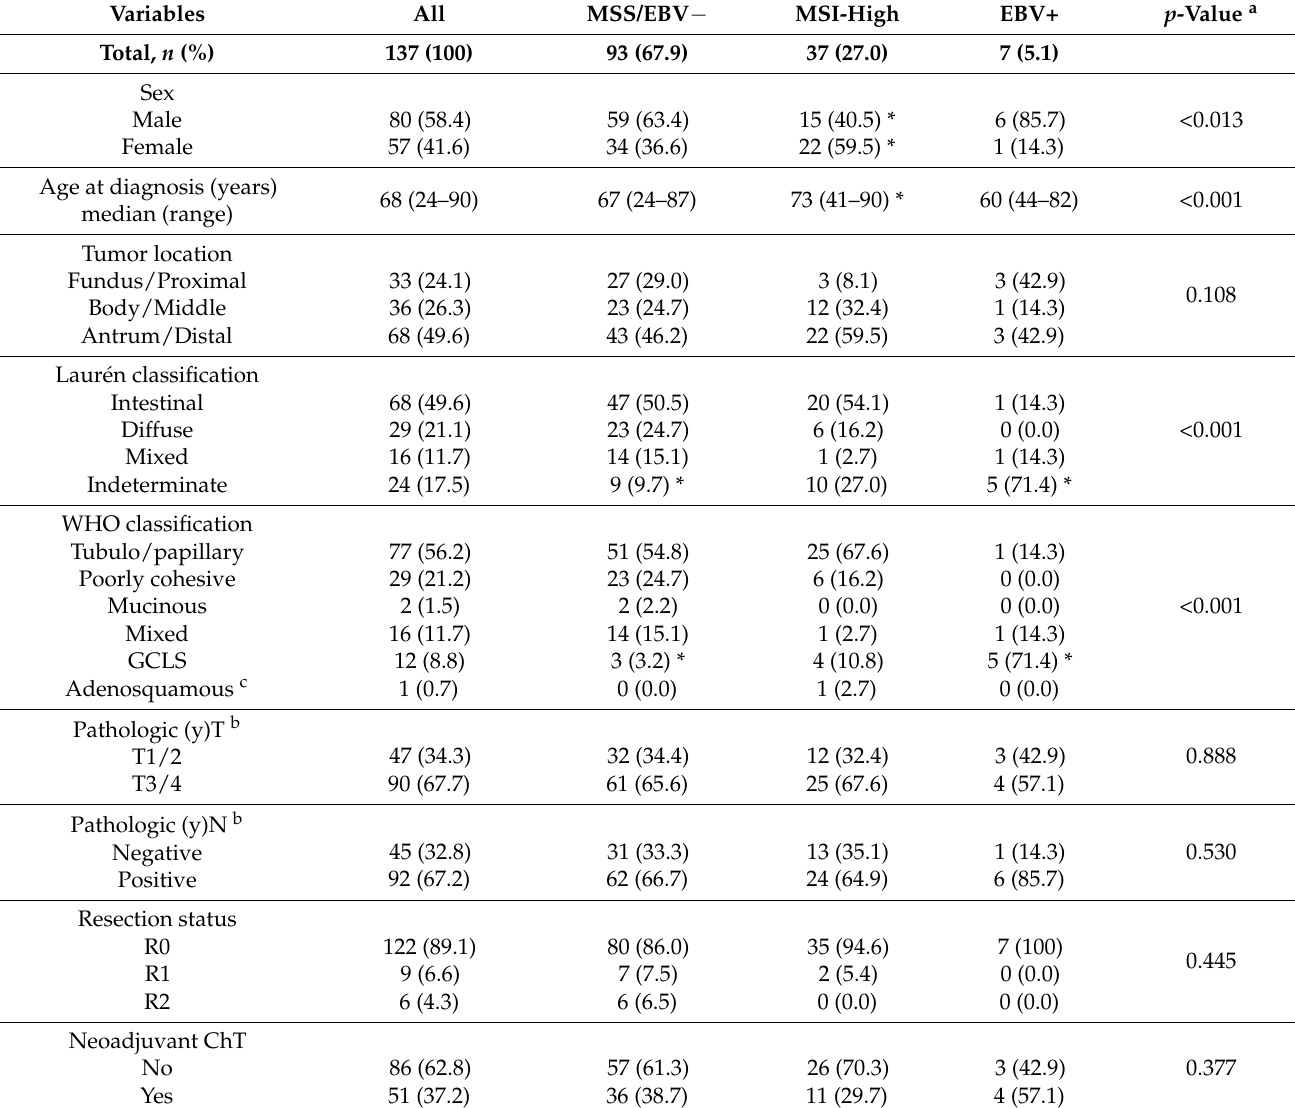
Table 1. Clinical and morphologic characterization for all tumors and according to molecular